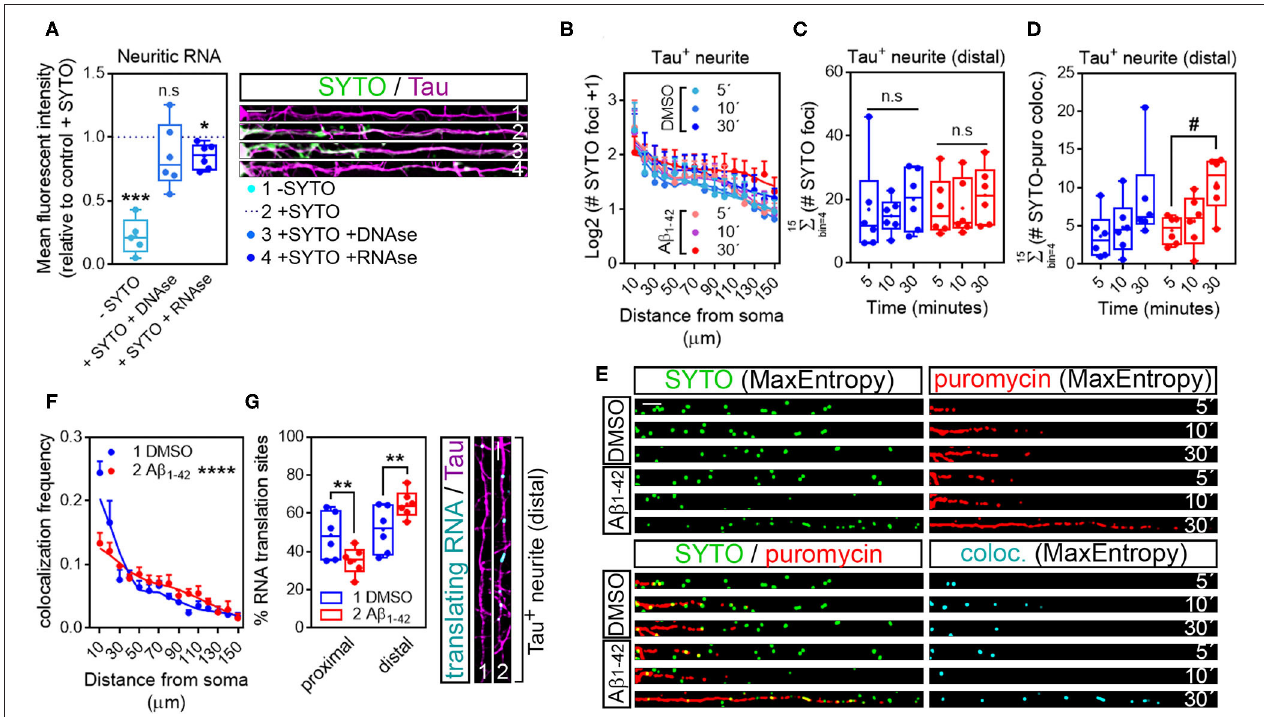
FIGURE 5 | Puromycin-positive foci in axons are a result of local protein synthesis. (A) Cells grown for 9 DIV and treated with DMSO for 24h. Cells immunostained with an anti-Tau antibody (magenta) were incubated with SYTO RNASelect green fluorescent dye to label endogenous RNA (green). Total green fluorescence intensity was measured in neurites covering a distance of 150 µ m from the edge of the soma (2, + SYTO). As negative control, green fluorescence was measured in cells that had not been incubated with SYTO (1, -SYTO). To determine if SYTO selectively labeled RNA, some fixed cells were digested with DNAse (3, + SYTO + DNAse) or with RNAse (4, + SYTO + RNAse). Box and whisker graphs represent the average relative fluorescence intensity of 10 neurites per condition, shown as individual data points, and the mean and median of 5 ( n = 5, − SYTO negative samples compared to their corresponding + SYTO controls) or 6 ( n = 6, + SYTO + DNAse and + SYTO + RNAse compared to their corresponding + SYTO controls) independent experiments. *** p < 0.001; * p < 0.05; n.s, not significant; two-tailed t -tests. Scale bar, 10 µ m. (B) SYTO-positive staining [as represented in green in (E) ] from randomly selected cells was filtered with the convolver, brightness and contrast were adjusted. Images were converted to 8-bit and binarized with the MaxEntropy mask. The longest Tau-positive neurite was selected with a segmented line and straighten, smoothen and binarized with the MaxEntropy mask (MaxEntropy). SYTO-positive discrete puncta were scored with the particle analyzer in 15 bins covering a distance of 150 µ m from the edge of the soma. The graph shows the average number on puncta represented as Log2 (SYTO foci + 1) vs. distance ± SEM measured in 6 independent experiments ( n = 6). No statistical differences were detected between DMSO- and A β -treated cells incubated with puromycin for 5, 10, or 30 mins. (C) Box and whisker graphs show the total number of RNA granules in distal sites of Tau-positive neurites [ Σ (# SYTO foci)] from DMSO- and A β -treated cells incubated with puromycin for 5, 10, or 30 mins. Data represent the average value of 10 sampled cells per condition plotted as individual data points, and the mean and median of 6 independent experiments ( n = 6). n.s, no significant; two-way ANOVA followed by Tukey’s multiple comparison test. (D) Parallel to processing SYTO-labeled images, puromycin staining was filtered with the convolver, brightness and contrast were adjusted. Images were converted to 8-bit and binarized with the MaxEntropy mask. Same Tau-positive neurites selected for SYTO quantification (green channel) were selected in the red channel [puromycin staining in (E) ], straighten, smoothen and binarized with the MaxEntropy mask. Co-localized objects were obtained with the AND function in the image calculator [cyan in (E) ] and scored in distal sites of Tau-positive neurites with the particle analyzer. Box and whisker graphs show the total RNA-protein colocalized puncta in DMSO- and A β -treated cells incubated with puromycin for 5, 10, or 30 mins [ Σ (# SYTO-puro coloc.)]. Data represent the average value of 10 sampled neurites per condition plotted as individual data points, and the mean and median of 6 independent experiments ( n = 6). # p < 0.05 5 vs. 30min puromycin in A β -treated cells; two-way ANOVA followed by Tukey’s multiple comparison test. (E) Micrographs from straighten, binarized neurites stained with SYTO RNASelect green fluorescent dye to label RNA (green), with an anti-puromycin antibody to label protein (red) and the resulting images when merging both channels (green, red, and yellow) and when combining both with the AND function in the image calculator (cyan). Cells treated with puromycin for 5, 10, or 30 mins are shown. Scale bar, 10 µ m. (F) The graph represents the frequency distribution of SYTO- and puromycin-positive objects (colocalization frequency) in DMSO- and A β -treated neurites following 30-min puromycin exposure. Colocalized objects were measured with the particle analyzer in 15 bins covering a distance of 150 µ m from the edge of the cell body. **** p < 0.0001 (interaction); two-way ANOVA. (G) Box and whisker graph representing the proportion of colocalized objects (% RNA translation sites) in proximal (0–30 µ m) and distal (last 120 µ m) sites of Tau-positive neurites. Data represent the average value of 10 sampled cells per condition shown as individual data points, and the mean and median of 6 independent experiments ( n = 6). ** p < 0.01; two-tailed t -test. Micrographs show colocalized objects (translating RNAs, cyan) detected within the last 120 µ m (distal) of Tau positive neurites (magenta). Scale bar, 10 µ